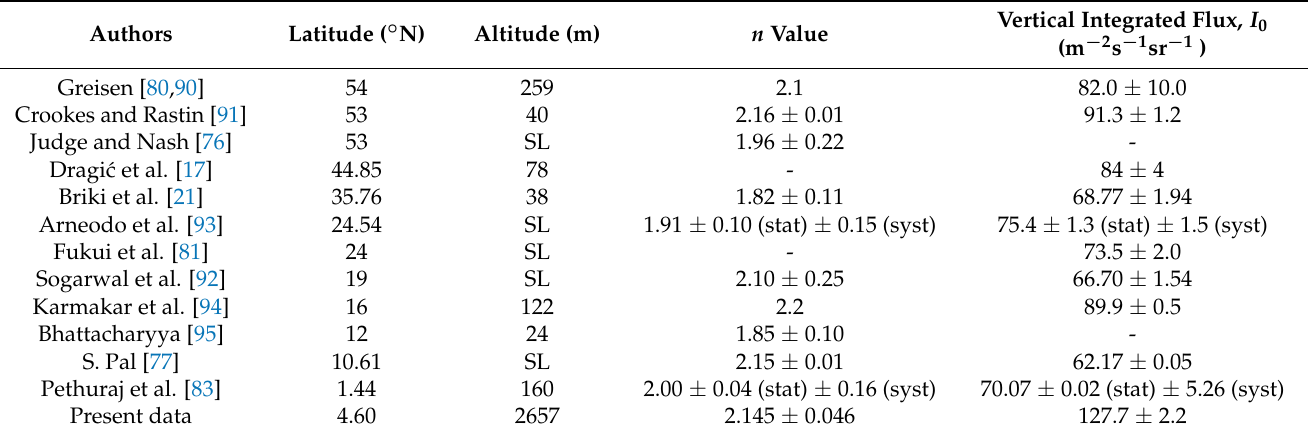
Table 3. Comparison of values of n and integral over flux with other